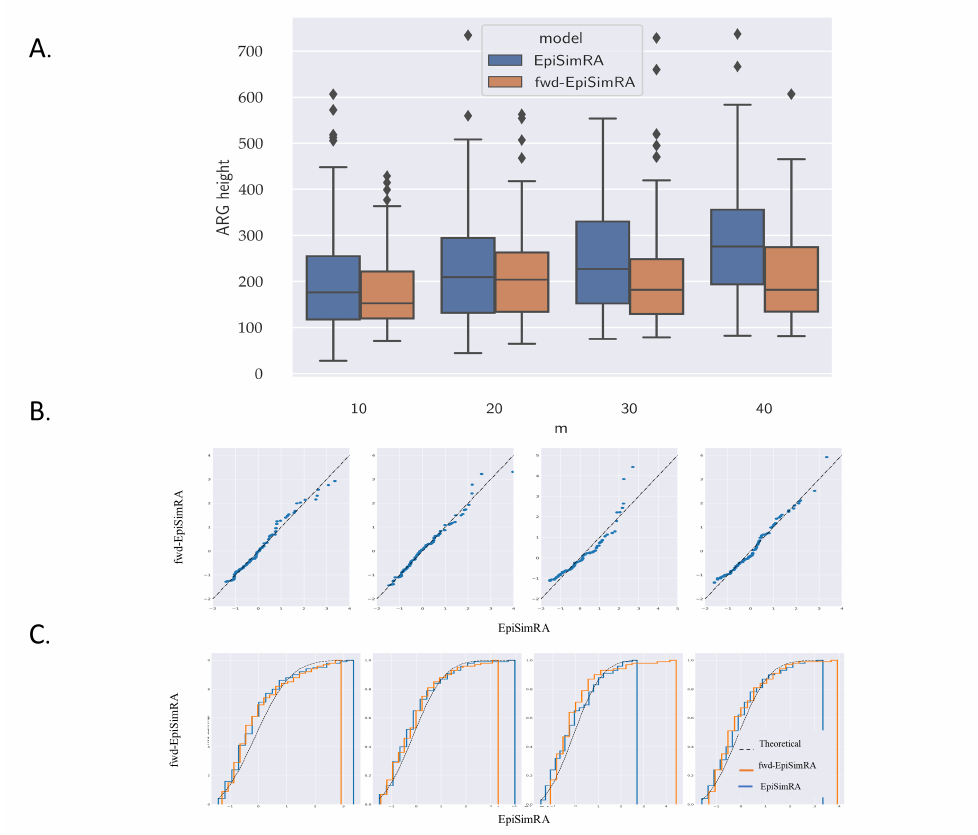
Figure 2. Comparison of the height of the ARG (H) between fwd-EpiSimRA and EpiSimRA with and without epistatis with recombination for N = 100, g = 250 kbp, r = 1.0 × 10 − 8 , m = { 10,20,30,40 } , s = { 0.3,0.3,0.3 } with epistastic parameters for s i s j = 0.15 for i , j ∈ [ 1,3 ] and s 1 s 2 s 3 = 0.125. ( A ) The box-and-whisker diagram summarizes the result for each. On each box, the central mark is the mean, the edges of the box are the 25th and 75th percentiles, the whiskers extend to the most extreme data points and outliers are plotted individually. ( B ) QQ plot and ( C ) Cumulative Distribution Function (CDF) plot of the backward and forward models show similar distributions with further agreement in Kolmogorov-Smirnov tests (Table